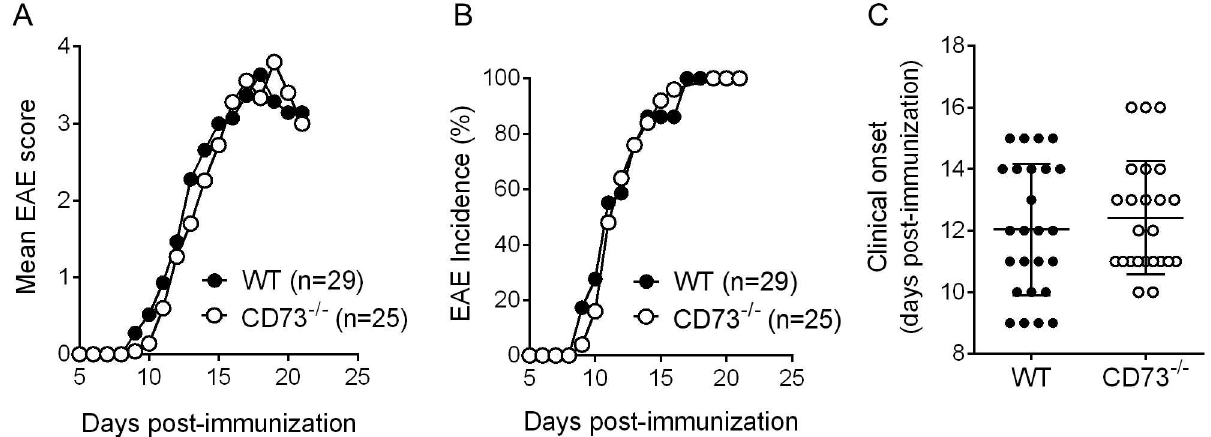
Fig 4. EAE clinical course is not affected by CD73 deficiency. A: Mean clinical scores followingEAE inductionin WT and CD73 -/- mice. B: Percentage of mice that had developed EAE clinicalsigns on indicateddays after EAE induction. C: Day of EAE onset in WT and CD73 -/- mice that developed signs of EAE by day 16 post-immunization(mean +/- S.D.). Data pooledfrom four independent experiments.